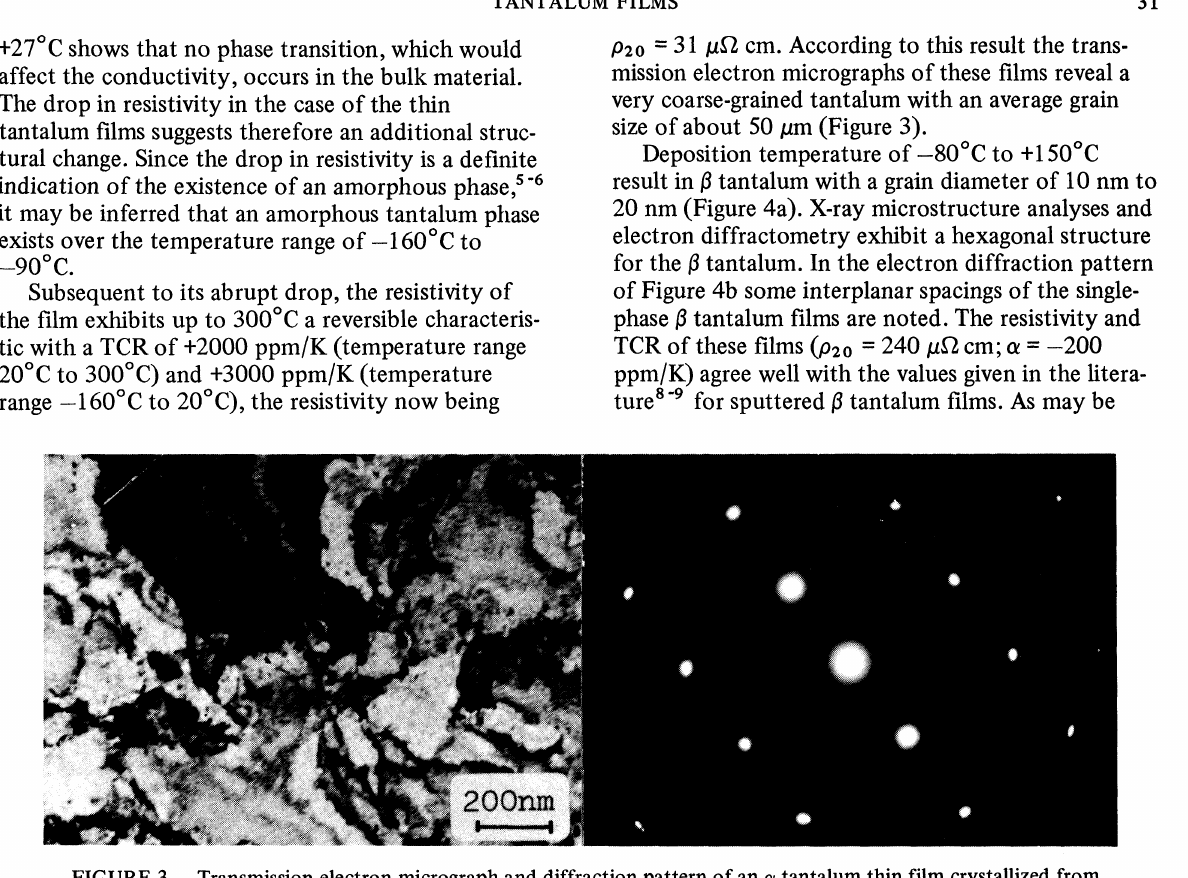
FIGURE 3 Transmission electron micrograph and diffraction pattern of an a tantalum thin film crystallized from the amorphous state (condensation temperature -160 C, heated to room temperature, film thickness d 60 nm).